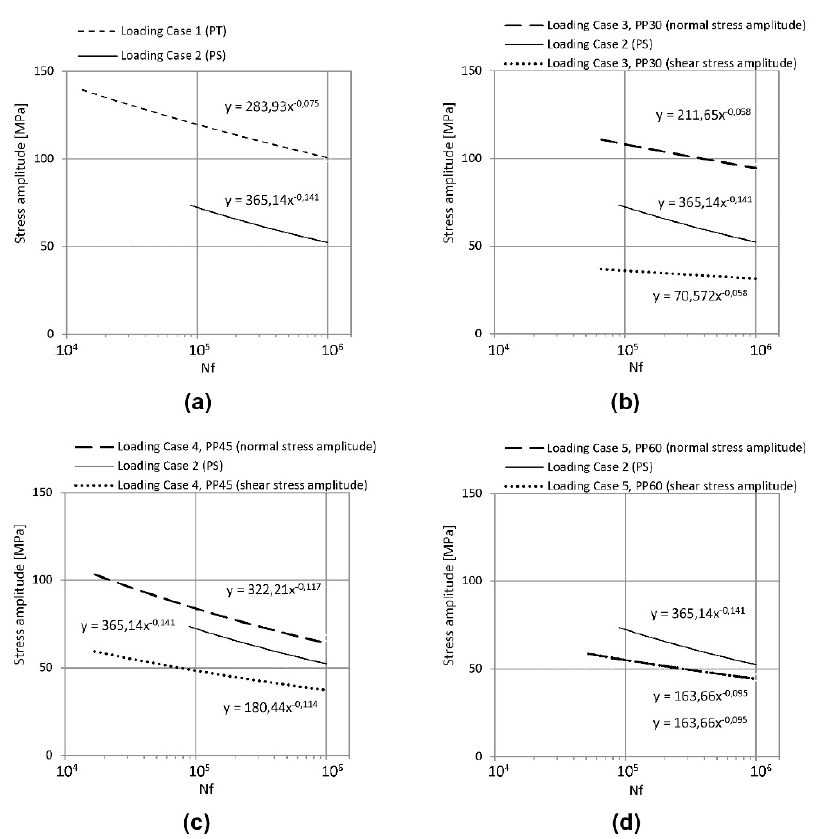
Figure 5. S-N experimental data and respective trend lines representation for loading Cases 1 to 5. ( a ) Case 1 PT and Case 2 PS, ( b ) Case 3 PP30, ( c ) Case 4 PP45, and ( d ) Case 5 PP60. Table 4. S-N trend lines for normal and shear loading components of loading cases 1 to 5 experimentally evaluated for AZ31B-F.